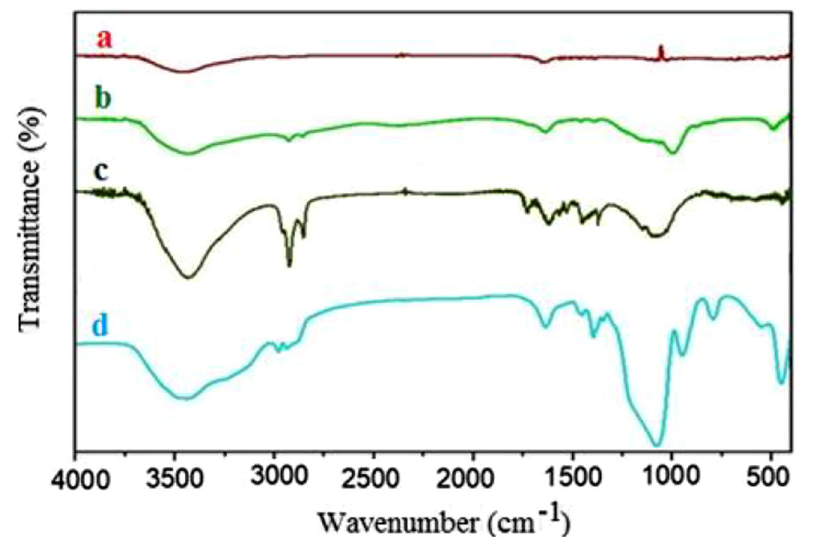
Figure 9: FTIR spectra of (a) GNRs, (b) GNRs@SBA-15-SH, (c) GNRs@SBA-15-SH/ DOX, and (d)